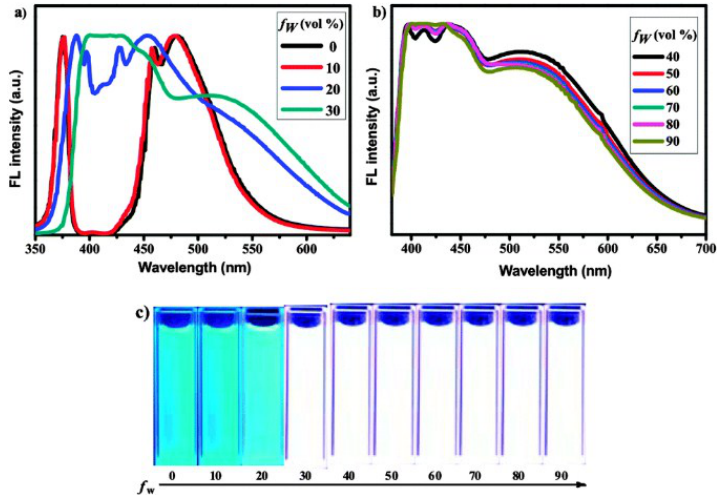
Figure 6. ( a ) Luminescence spectra of the dilute solutions of 9 (2.0 × 10 −5 mol·L −1 ) in dimethylformamide-water (DMF-H 2 O) mixtures with different volume fractions of water (0%, 10%, 20% and 30%). λ exc = 330 nm; ( b ) Luminescence spectra of the dilute solutions of 9 (2.0 × 10 −5 mol·L −1 ) in DMF-H 2 O mixtures with different volume fractions of water (40%–90%). λ exc = 365 nm; ( c ) The fluorescence images of 9 (concentration: 2.0 × 10 −5 mol·L −1 ) in different DMF-H 2 O mixtures with different water fractions (fw) under 365 nm UV irradiation. Reproduced from ref. [42] with permission from The Royal Society of